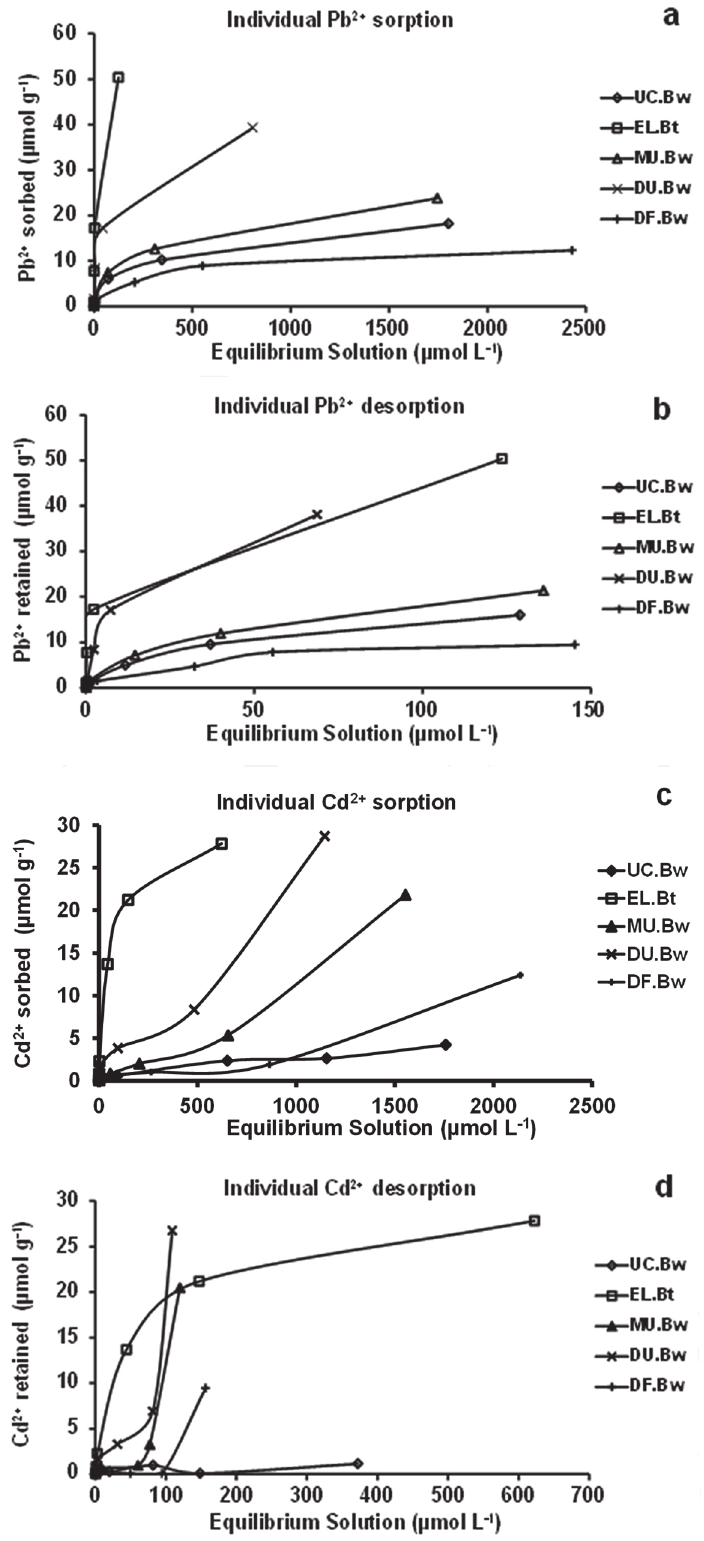
Fig 1. Individual sorption (a and c) and desorption (b and d) isotherms of Pb 2+ and Cd 2+ .